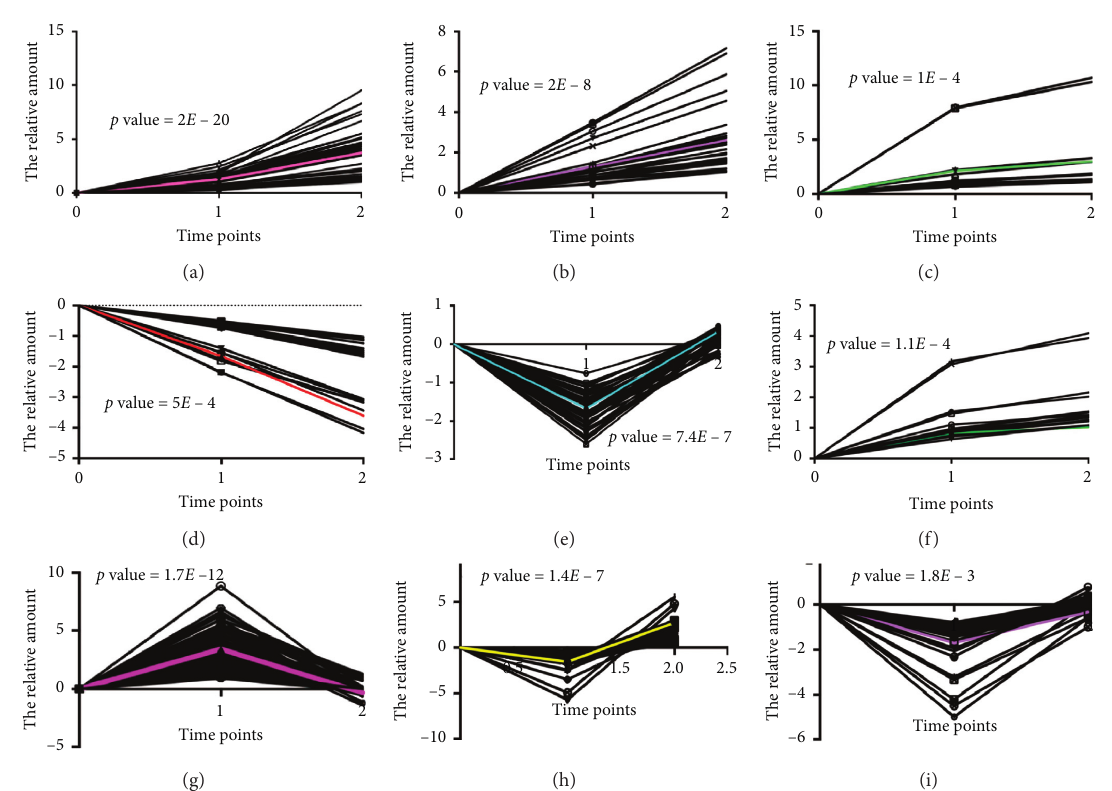
Figure 2: The extremely early altered metabolic pattern from the ascending aorta, coronary sinus, and peripheral vein after TAVR. (a–d) The altered metabolic pattern from the ascending aorta; (e, f) the altered metabolic pattern from the coronary sinus; (g–i) the altered metabolic pattern from the peripheral